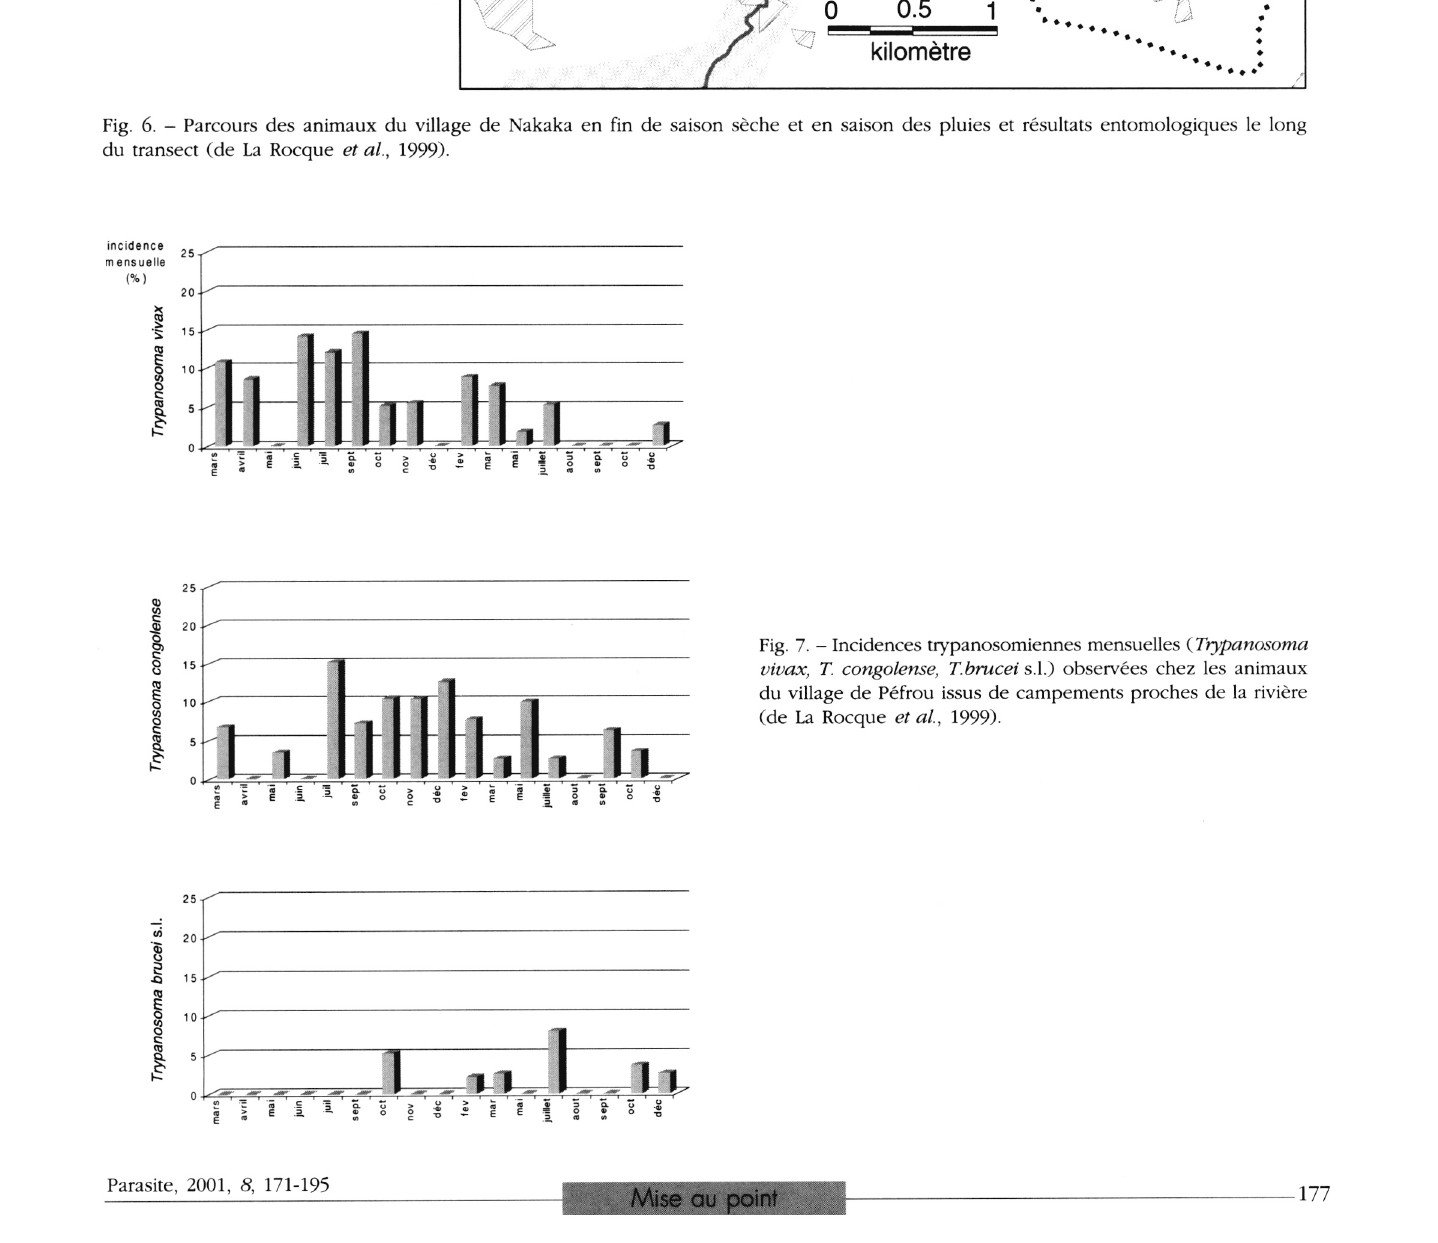
Parasite, 2001, 8, 171-195